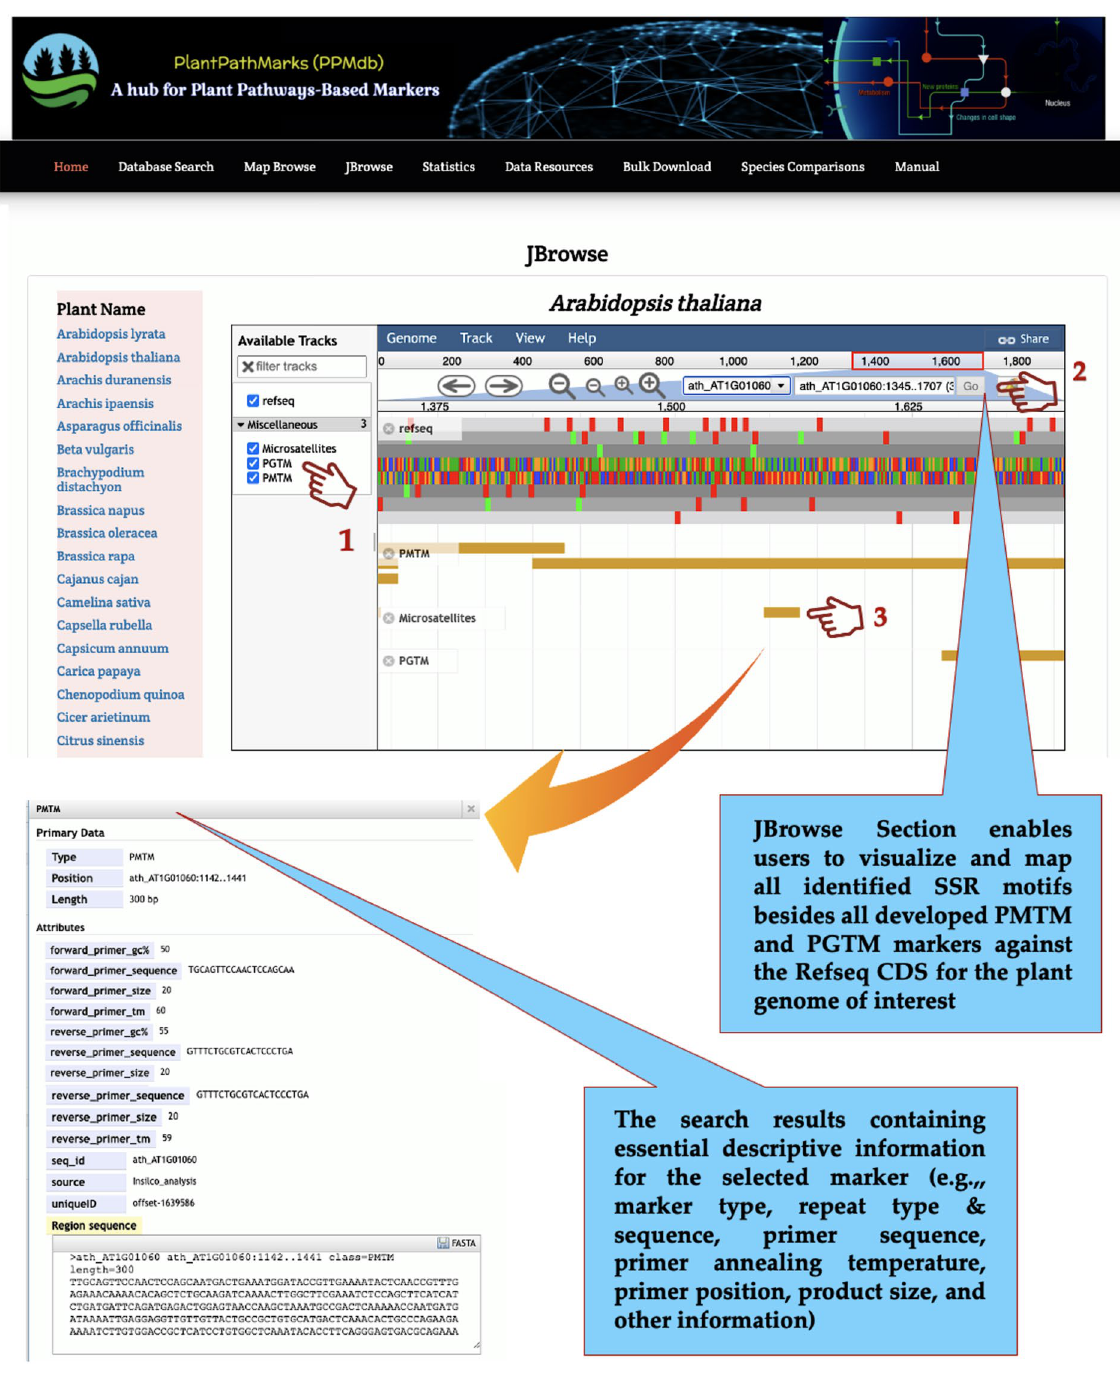
Figure 5. Screenshot of the PPMdb database “JBrowse”